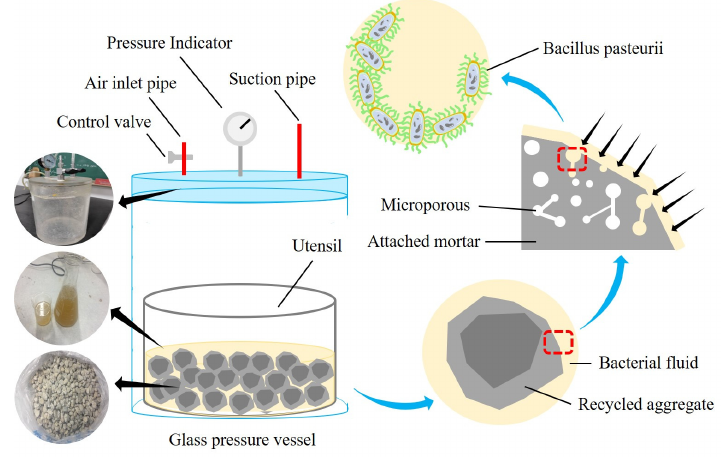
Figure 6. Schematic representation of microbial adsorption on the carrier.